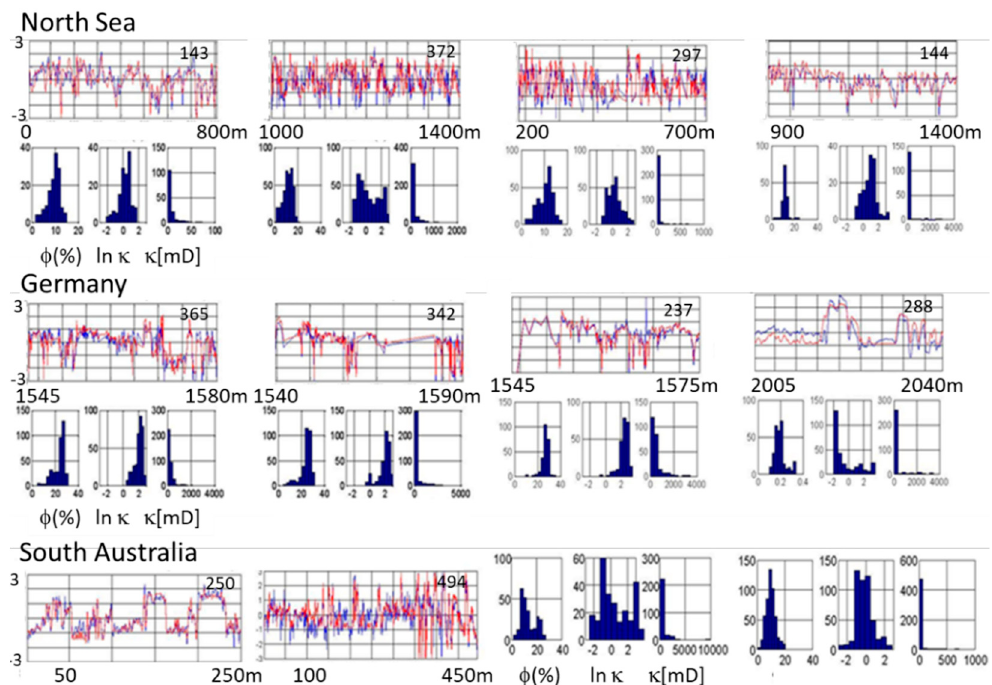
Figure 3. Porosity ( φ , blue ) and natural log permeability (ln κ , red) magnitudes in sub-vertical well cores from the North Sea (top), Germany (middle), and South Australia (bottom). Porosity and ln permeability are plotted against sample depth. Both are normalized to zero mean and unit variance. The number of measurements is shown on the plots. In the histograms, the porosity values are plotted as the number of values in 1% wide bins versus percent porosity. Both ln permeability and permeability data are plotted as the number of values in bins versus millidarcies (mD).